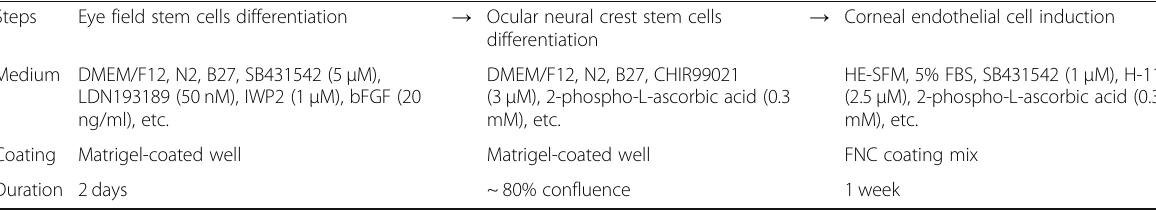
Table 4 The summary of Zhao ’ s methods (2016) Steps Eye field stem cells differentiation → Ocular neural crest stem cells